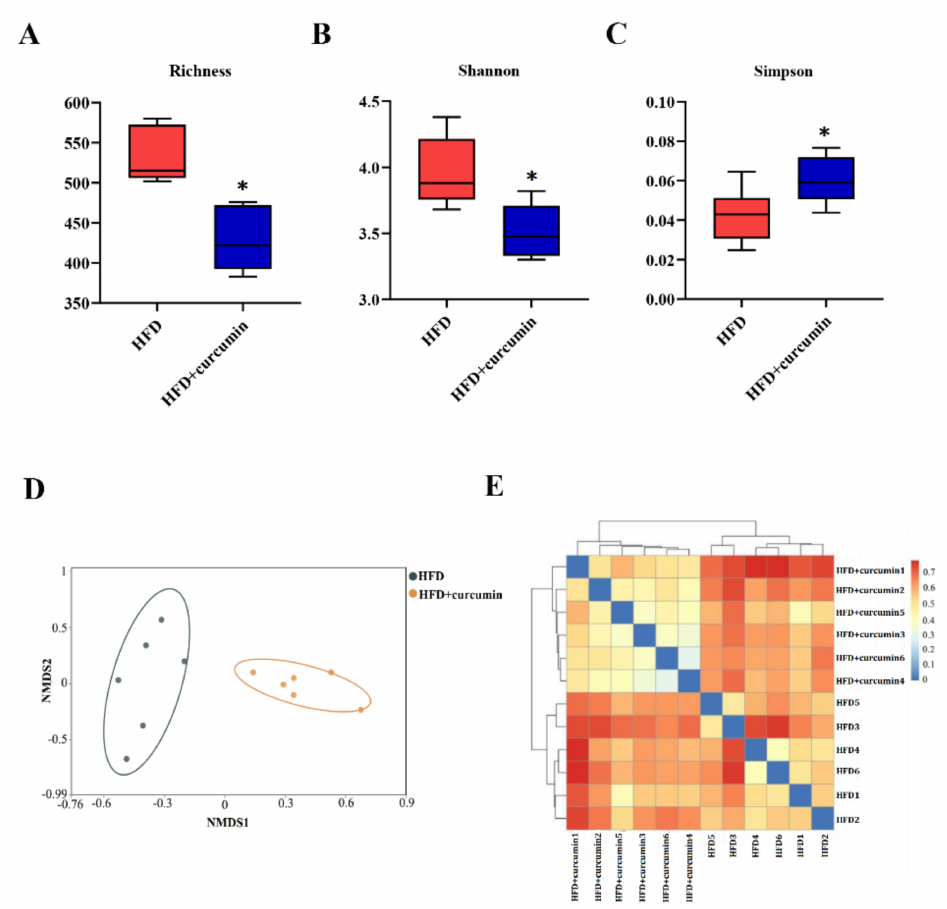
Figure 4. Effects of curcumin on gut microbiota composition in HFD-fed hamsters. ( A – C ) α -diversity analysis including richness, Shannon index and Simpson index of gut microbiota. ( D , E ) β -diversity analysis of gut microbiota including NMDS plot and sample distance heat map. Data are